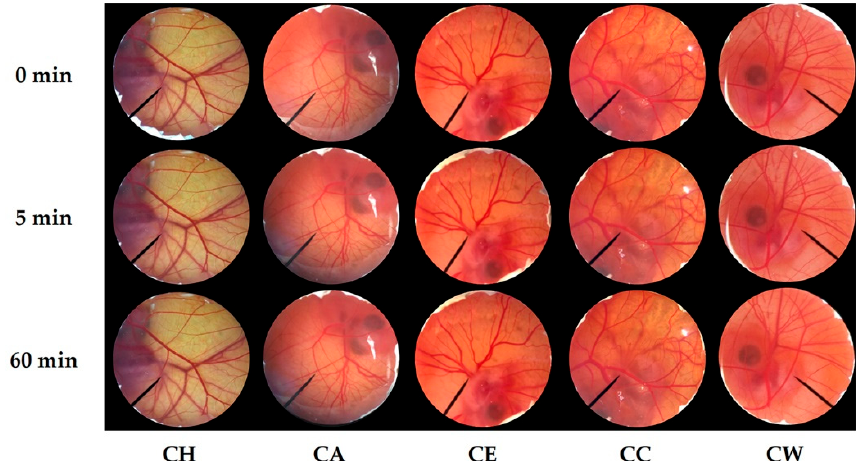
Figure 5. E ff ect of C. militaris extracts, including hexane extract (CH), ethyl acetate (CA), ethanolic extract (CE), crude ethanolic extract (CC), and water extract (CW) on chorioallantoic membrane before (0 min) and after 5 and 60 min of exposure.